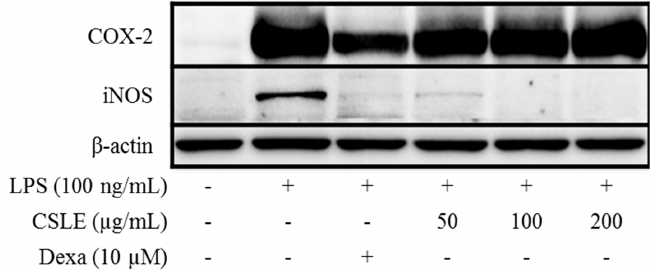
Figure 2. iNOS and COX-2 protein expression in LPS-stimulated RAW 264.7 macrophage. Cells were pretreated with CSLE (50, 100, and 200 μ g/mL) and dexamethasone (10 μ M) for 1 h before exposure to LPS (100 ng/mL) for 3 h (COX-2) and 18 h (iNOS). Cytosolic lysates were separated using SDS-PAGE. The iNOS, COX-2, and β -actin were detected using western blot analysis.